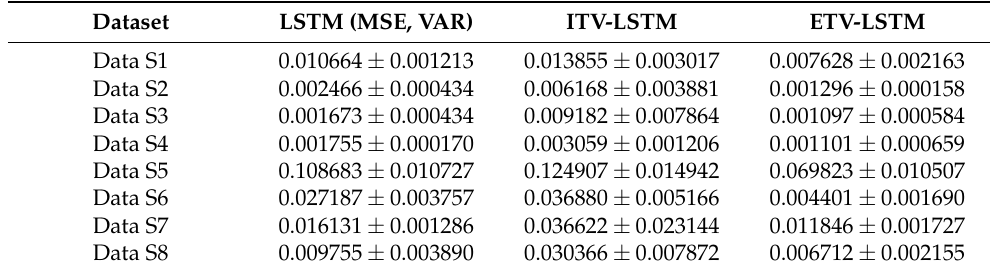
Table 3. Predictive performance of LSTM, ITV-LSTM, and ETV-LSTM methods on different simulated datasets. The average MSE and variance were obtained using five-fold